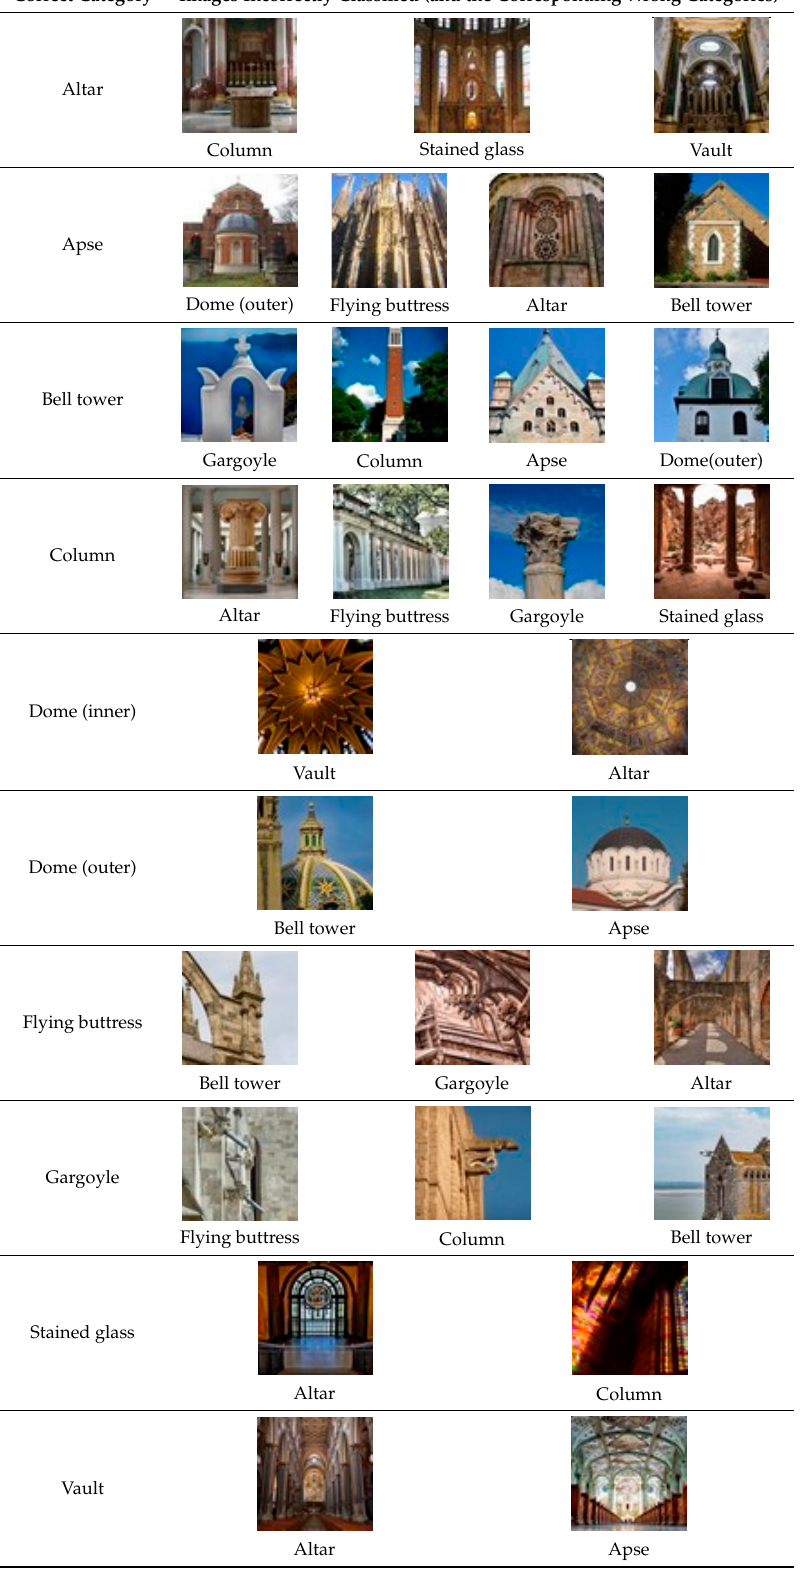
Table 12. Examples of images incorrectly classified by the convolutional neural networks used. Correct Category Images Incorrectly Classified (and the Corresponding Wrong Categories)